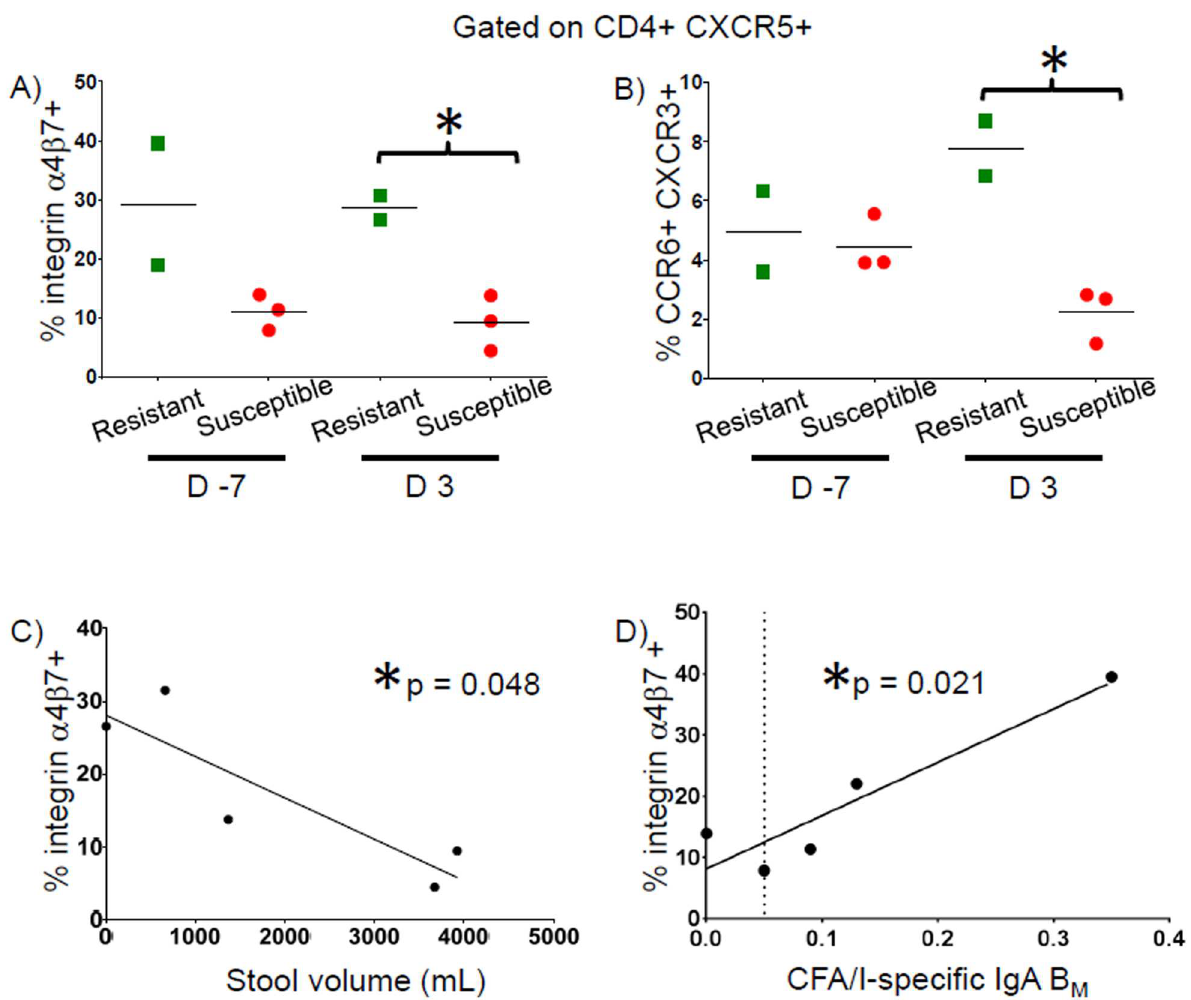
Fig 5. Percentages of pT fh expressing integrin α 4 β 7and other homing molecules in Resistant and Susceptible volunteers and association with stool volume and IgA B M . A) Percentagesof pT fh (CXCR5+) expressingintegrin α 4 β 7(integrin α 4 β 7+CCR4-) followingstimulationwith CFA/I at baseline(D -7) and 3 days post-challenge (D3). B) Percentagesof pT fh (CXCR5+) expressingCCR6 and CXCR3 (CCR6+ CXCR3+) followingstimulationwith CFA/I at baseline(D -7) & 3 days post-challenge (D3). C)